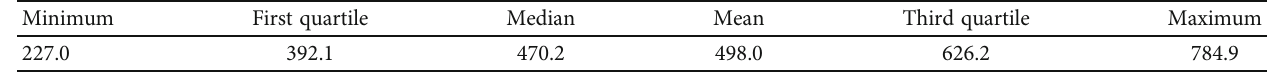
Table 3: Summary statistics of maximum rainfall intensity (mm).